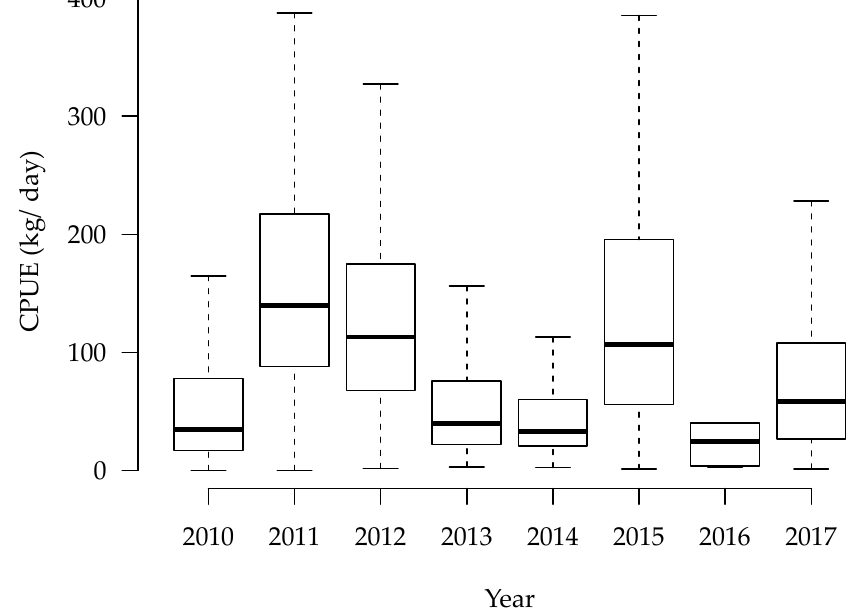
Figure 3. Nominal catch-per-unit-of-effort (CPUE) series (kg/day) of skipjack tuna from Indonesian drifting gillnet fishery between 2010 and 2017.